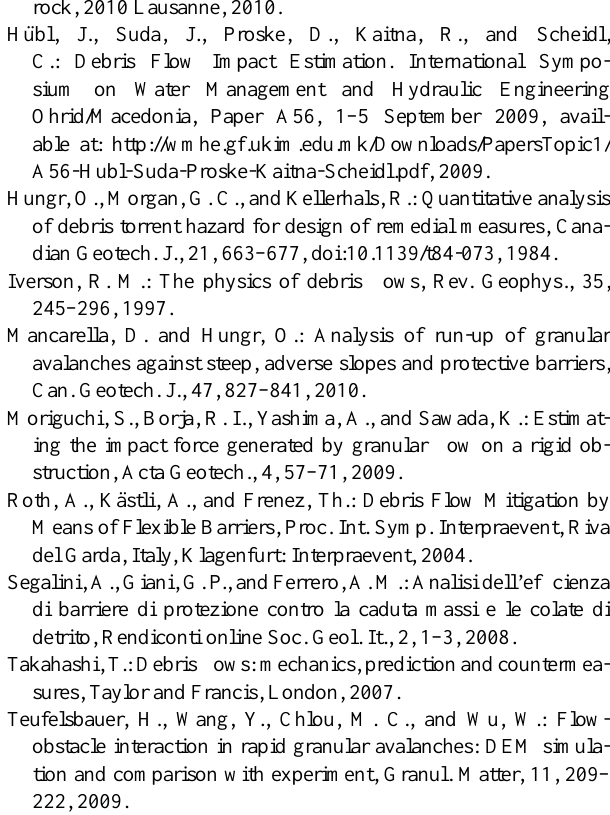
Fig. A3. Impact sequence, taken from Camera 1, for the rigid drain- ing barrier vertically mounted. (A) debris flows at the onset of im- pact, (B) initial phase of the impact, (C) development of a very small vertical jet-like wave, (D–F) the small jet-like wave returns inside the channel without any considerable increment of the pres- sure peak.